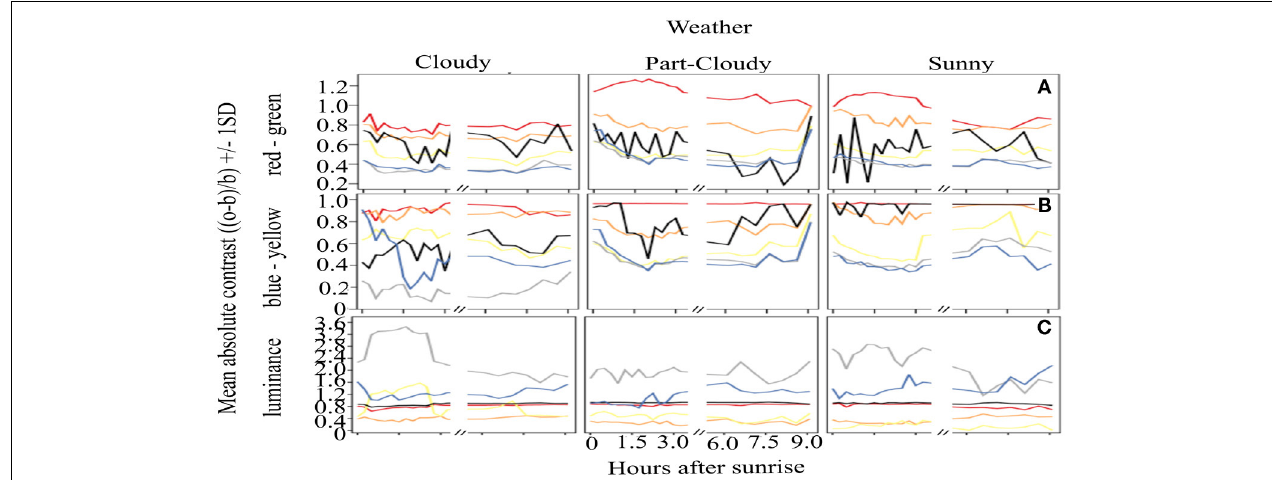
FIGURE 2 | Absolute contrast of the different color signals analyzed over the course of a day. Vertical panels show the absolute contrast of the different colors on the three opponent channel activation systems analysed [ (A) (RG), (B) (BY), (C) , Lum] while horizontal panels show the contrast according to the different weather conditions.